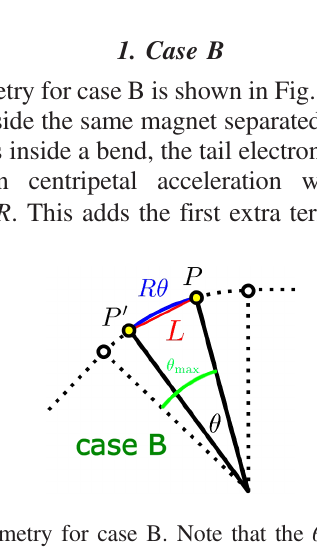
here corresponds to the max